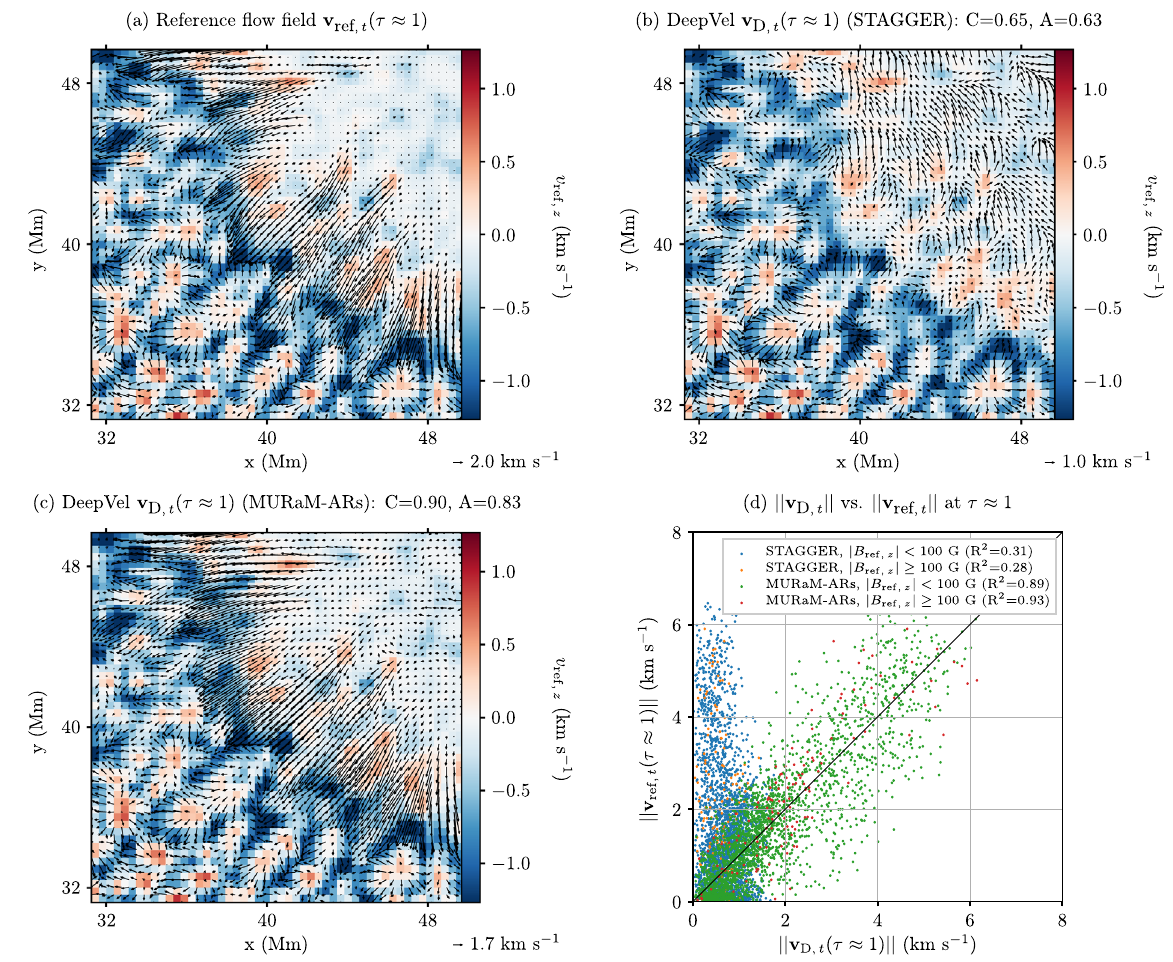
Fig. 4. At the surface velocity inversions, MURaM-ARs dataset. Patches of 50 (cid:3) 50 pixels 2 extracted from 30-timestep-averaged transverse velocity fi eld maps which were computed at optical depth s (cid:2) 1 by (a) the MURaM-ARs simulation (Rempel & Cheung, 2014), (b) the DeepVel neural network that generated Figure 1a, and (c) a version of the DeepVel neural network which was trained using the MURaM-ARs simulation resampled at the SDO/HMI spatial resolution ( D x (cid:2) 368 km). The vertical component of the velocity computed by the MURaM-ARs simulation is displayed as colored background. (Right column) Scatterplots comparing amplitudes || v D , t || to || v ref, t ||. The black line represents the expected solution (i.e., a coef fi cient of determination R 2 =